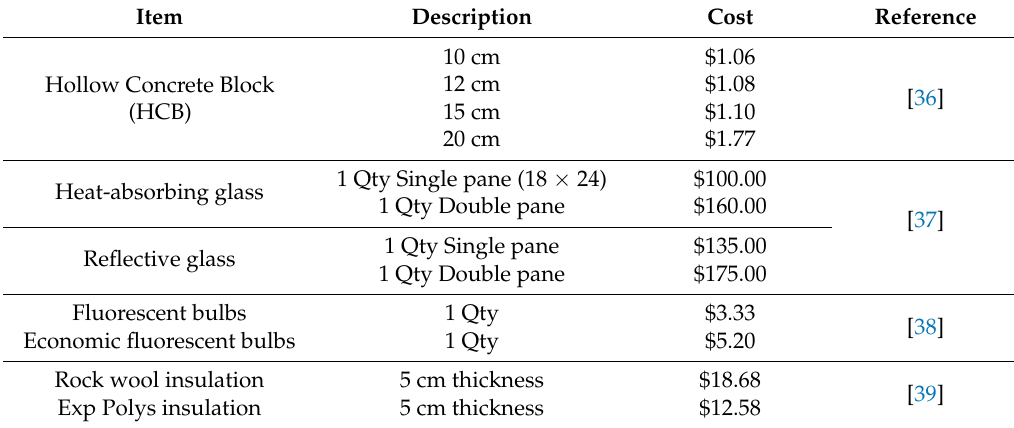
Table 3. The considered material prices.